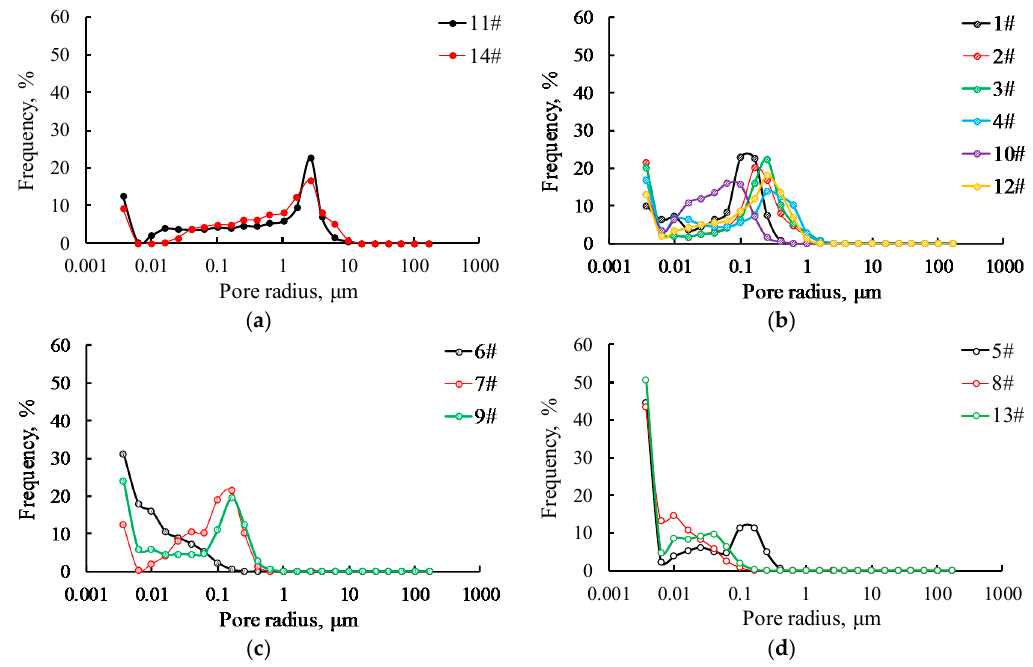
Figure 5. PCMI-derived PSD of four types of tight sandstones. ( a ) type α ; ( b ) type β ; ( c ) type γ ; ( d ) type δ .